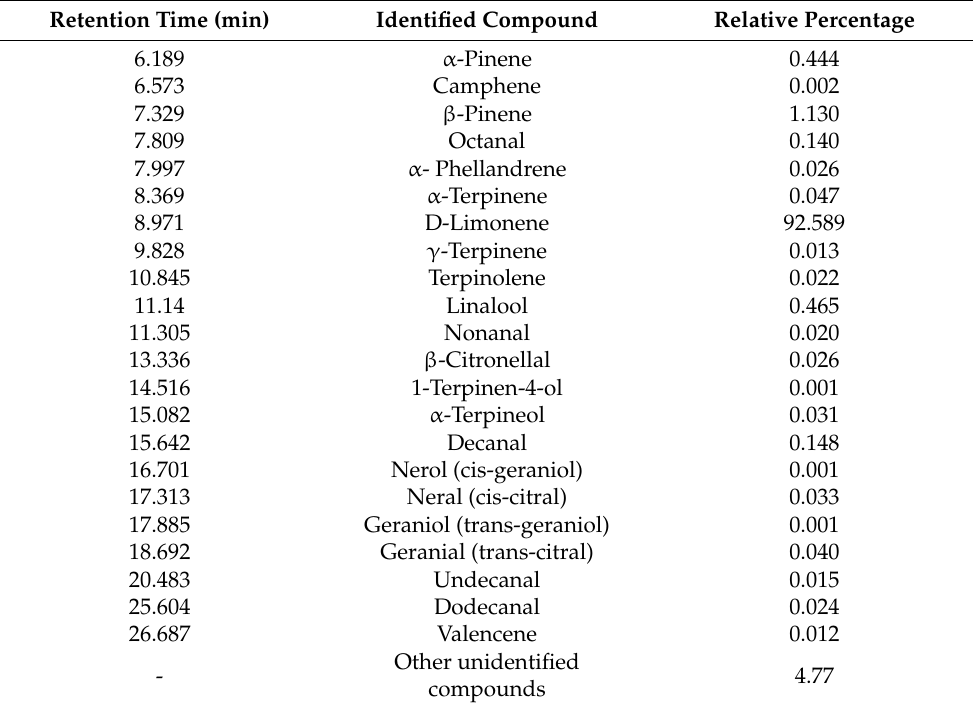
Table 2. Retention time, identified compounds, and relative percentage of orange essential